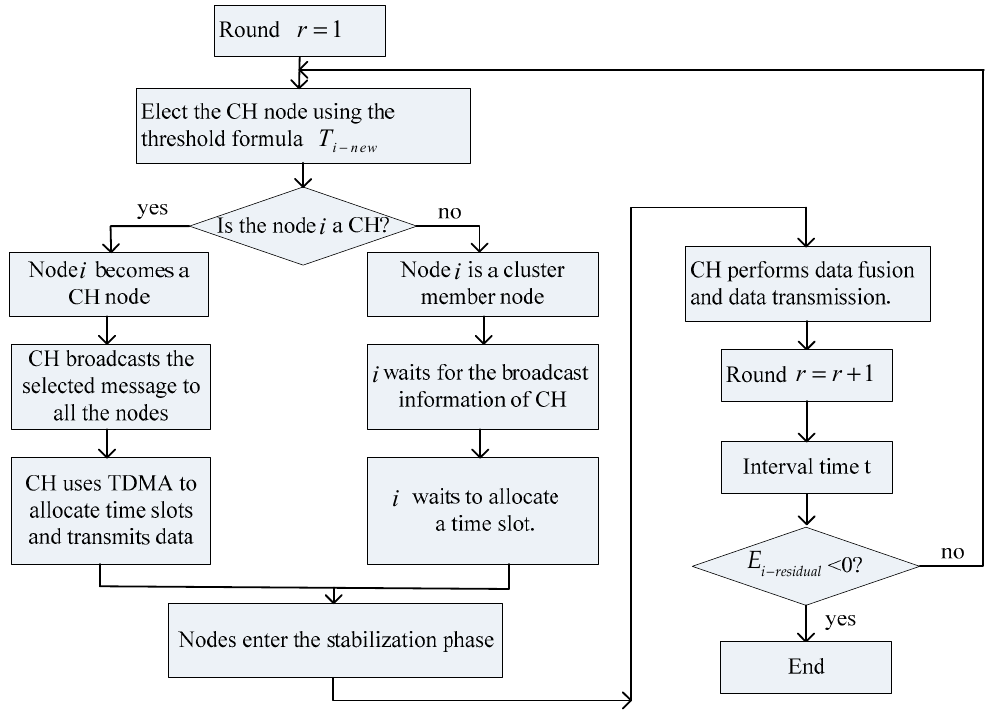
Figure 3. The improved clustered low energy adaptive clustering hierarchy(ICL-LEACH) algorithm flow chart.